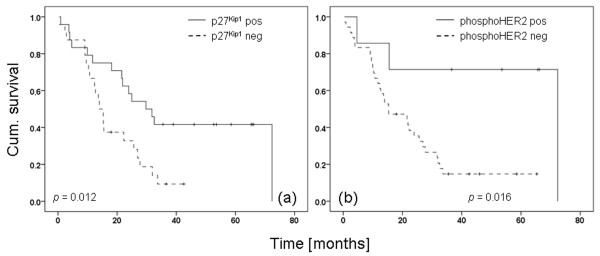
Kaplan-Meier curve of p27Kip1 and HER2pY1248 in Herceptin™-treated breast cancer patients. (a) Dichotomised p27Kip1 immunohistochemistry (P = 0.012) and (b) phosphorylated HER2 receptor immunohistochemistry (P = 0.016). HER = human epidermal growth factor receptor.